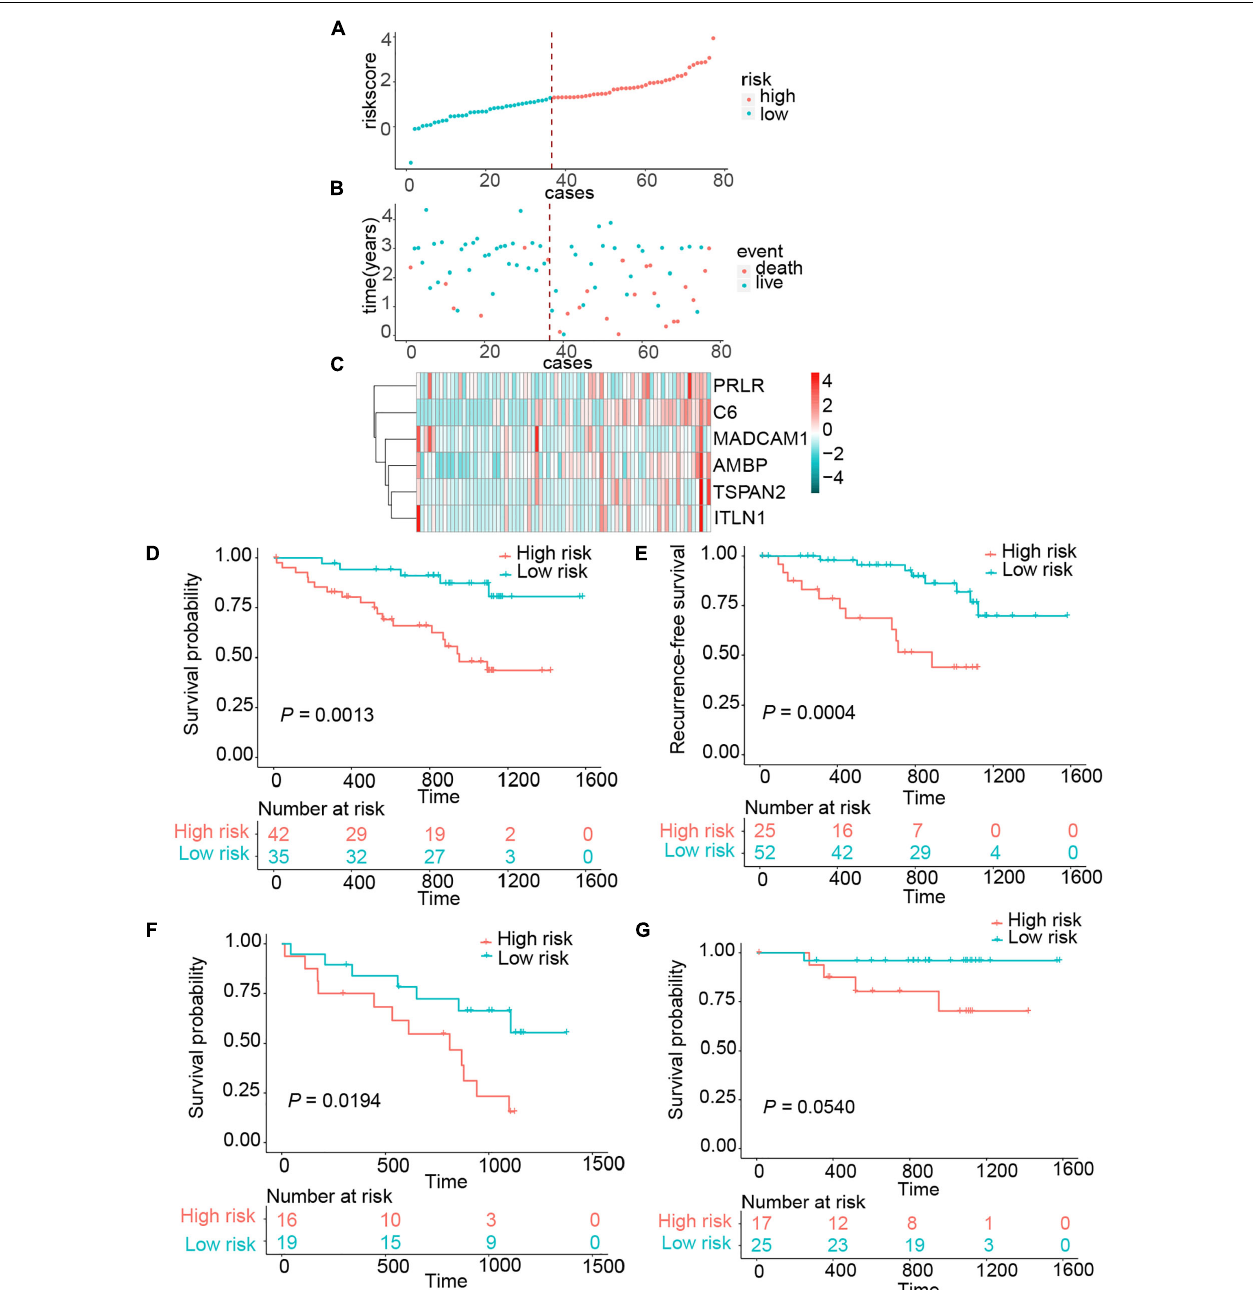
FIGURE 3 | Risk score distribution and survival of patients in the clinical validation cohort. (A) The risk scores for 77 patients of the clinical validation cohort. (B) The survival of each patient in the clinical validation cohort. (C) Expression distribution of the six genes in the clinical validation cohort. (D,E) Kaplan–Meier curve of OS and RFS in clinical validation cohort. (F,G) Kaplan–Meier curves of OS in LN + and LN - patients of clinical validation